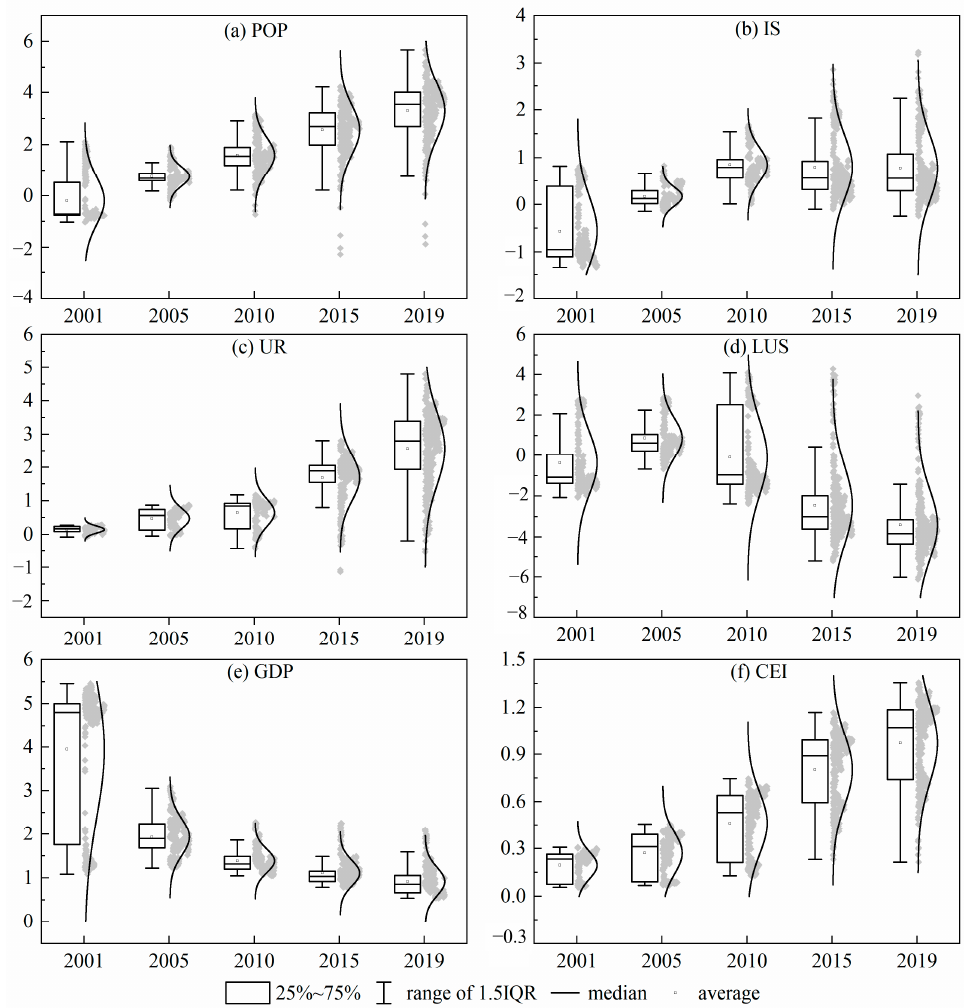
Figure 8. Time trend of the regression coefficients of factors.